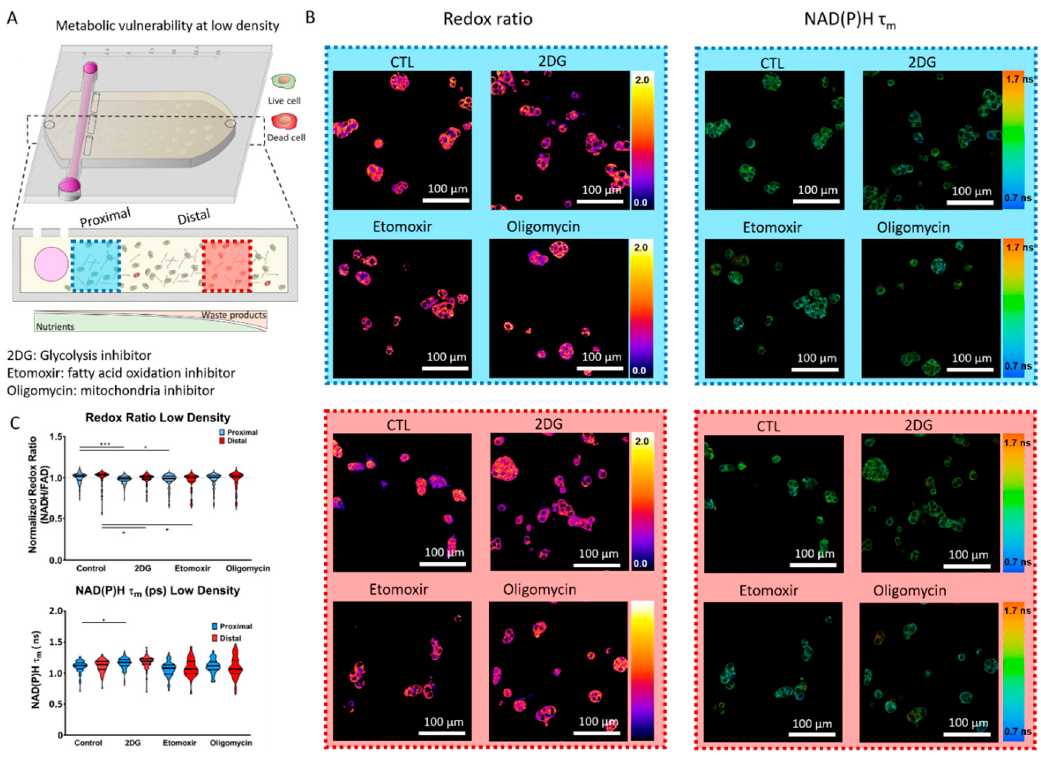
Figure 3. Optical metabolic imaging (OMI) in low cell density cultures. ( A ) Breast cancer MCF7 cells were cultured in the tumor-on-a-chip microdevice at 3 million cells/mL for 24 h in culture medium (CTL), or in the presence of 2-Deoxy-D-glucose (2DG), etomoxir, or oligomycin. After 24 h, cells were imaged using a multi-photon OMI. Nicotinamide adenine (phosphate) dinucleotide (NAD(P)H) and flavin adenine dinucleotide (FAD) autofluorescence were visualized and the ratio between NAD(PH) and FAD intensity was used to calculate the MCF7 cell optical redox ratio. NAD(P)H mean lifetime ( τ m ) was also calculated in nanoseconds (ns) to monitor changes in the MCF7 cell metabolic phenotype. Cell metabolism was evaluated in the proximal (blue square) and distal (red square) area. ( B ) Left panels: Multi-photon OMI shows the optical redox ratio of MCF7 cells located in the proximal and distal area, respectively. Right panels: Multi-photon OMI shows the NAD(P)H τ m of MCF7 cells located in the proximal and distal area, respectively. ( C ) Top graph: Violin plot shows the optical redox ratio normalized to the respective control (proximal or distal area) for each condition. Bottom graph: Violin plot shows the analysis of NAD(P)H τ m in the proximal and distal area. * and *** denote p -value < 0.05 and 0.001, respectively.